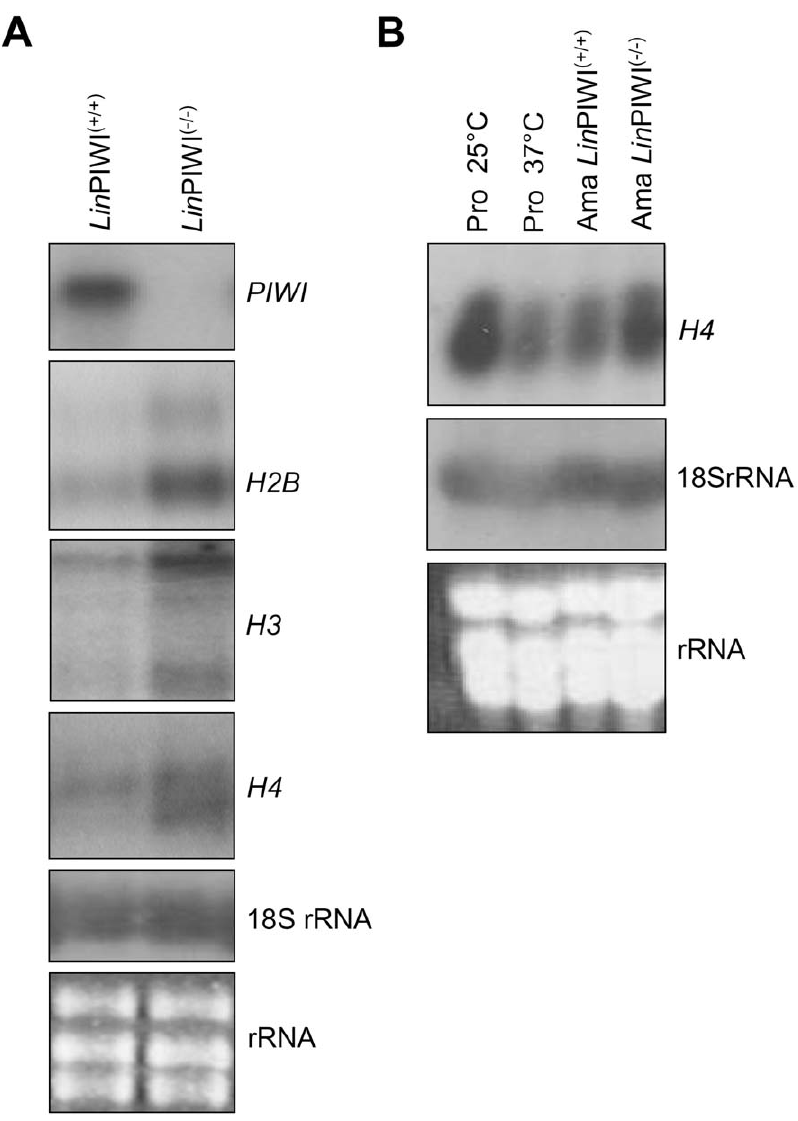
Figure 5. The histone mRNAs are upregulated in the L.infantum PIWI 2 / 2 null mutant. (A) Northern blot hybridization of total RNA isolated from wild type Lin PIWI ( + / + ) and Lin PIWI ( 2 / 2 ) axenic amastigotes to evaluate changes in the accumulation of the histone H2B (LinJ.19.0030), H3 (LinJ.10.0920) and H4 (LinJ.21.0020) transcripts. Hybridization was carried out with radiolabeled PIWI ORF and histone ORF probes. There are two bands hybridizing with the H2B and H3 gene probes as reported previously [41,43]. (B) Northern blot hybridization to confirm upregulation of the H4 transcript in Lin PIWI ( 2 / 2 ) amastigotes or in heat-stressed promastigotes compared to unstressed parasites. The 18S RNA blot hybridization and EtBr- stained gels were used as loading controls.